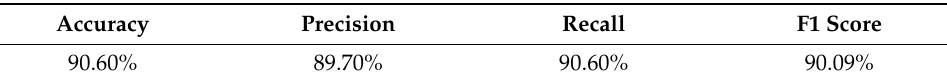
Table 5. XGBoost Model Confusion